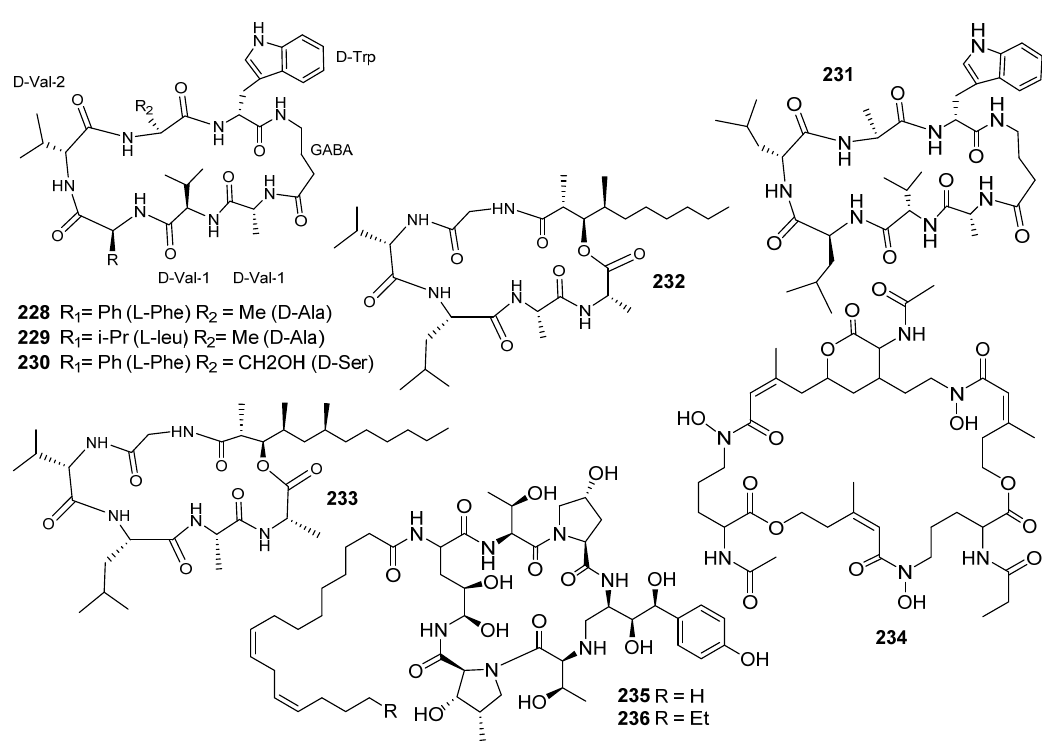
Figure 15. Structures of compounds 228–236.